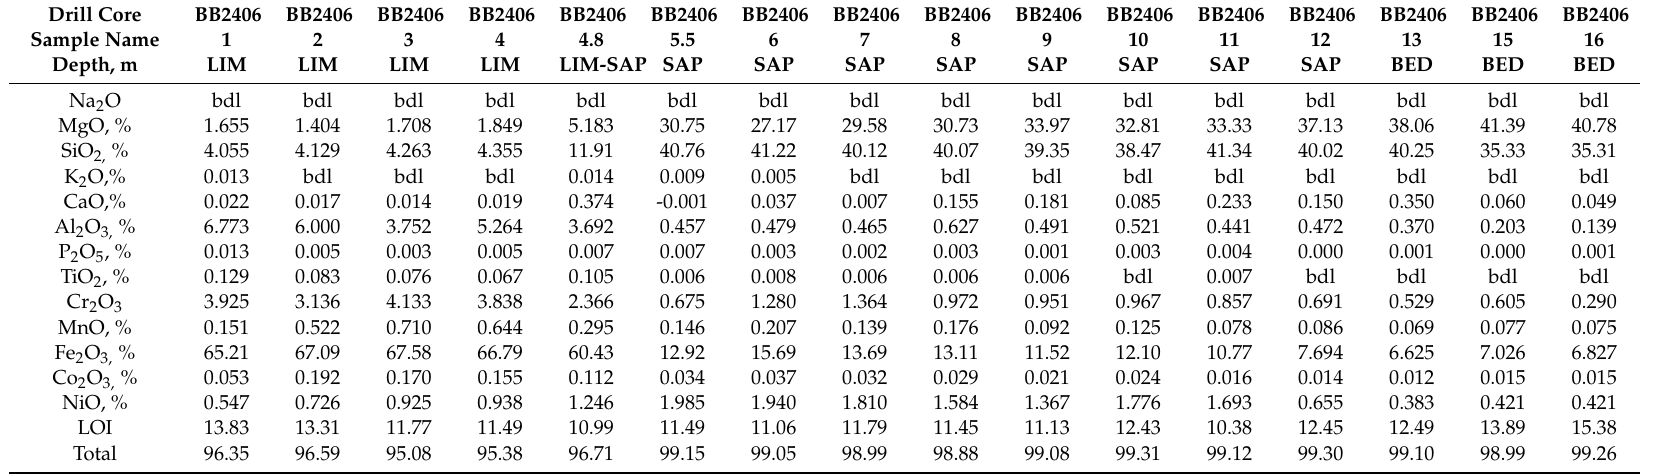
Table 9. Whole-rock chemical analyses (wt%) of the bedrock (BED), saprolite (SAP), and limonite (LIM) samples through BB2406